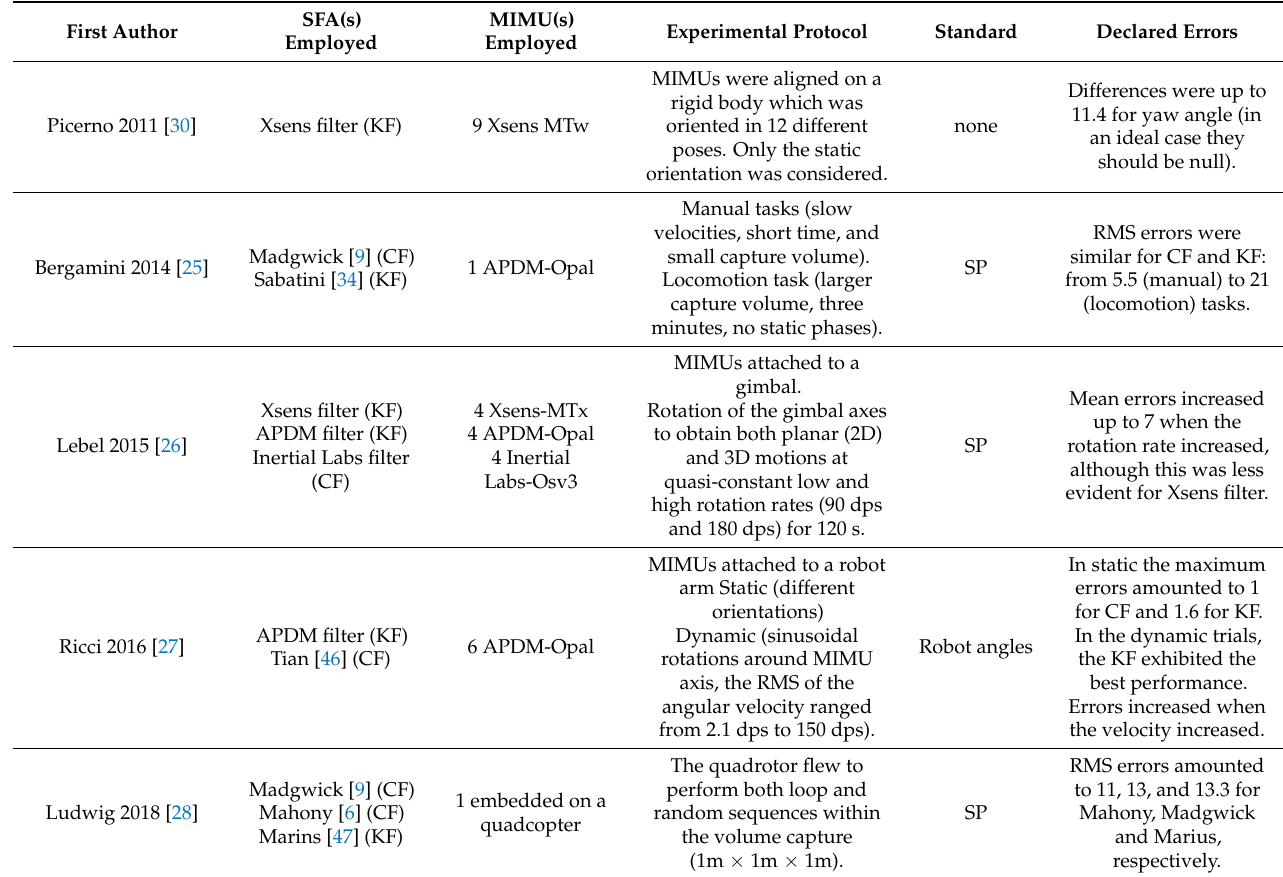
Table A1. Results of the Original Algorithm Studies. All the Error Units Are in